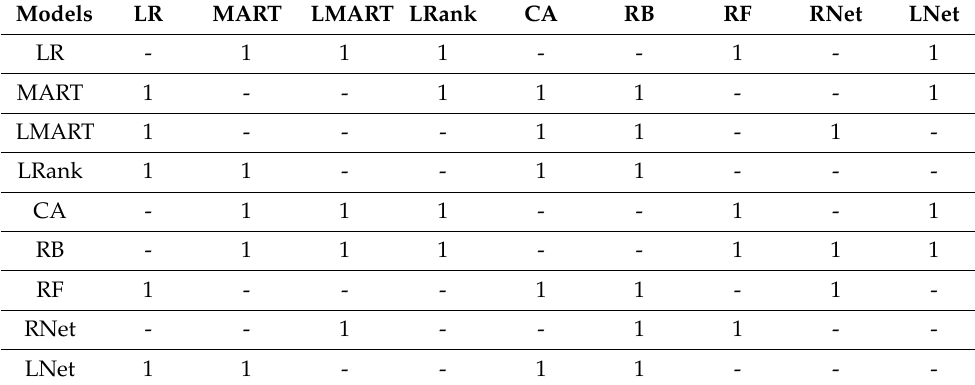
Table 5. A pairwise one-sided t-test is applied to each pair of the LtR model considering the nDCG metric. “1” indicates that a statistically significant difference among a pair was observed, whereas “-” indicates no statistical significance.